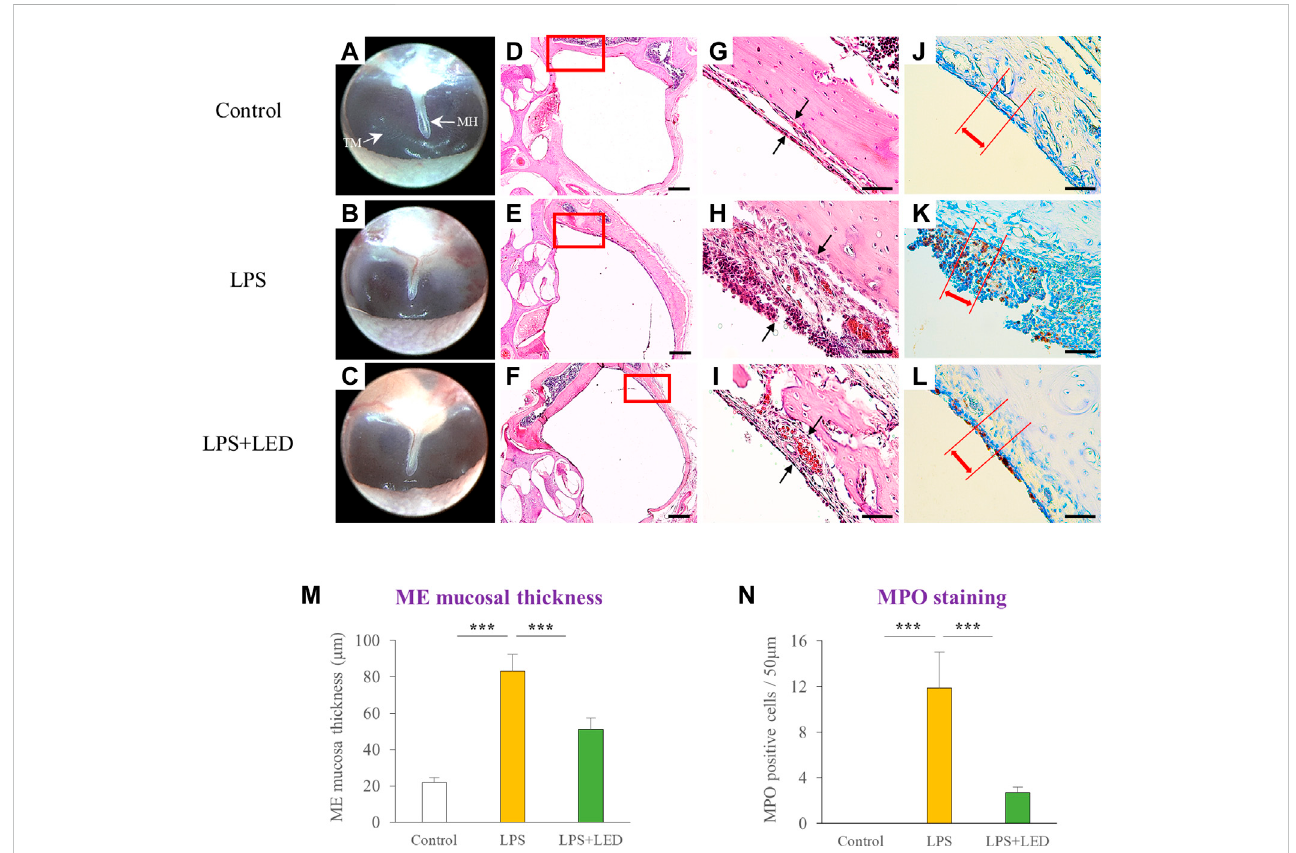
FIGURE 2 Reduction of ME mucosal thickness by LED irradiation. Representative otoscope images of the tympanic membrane of LPS-treated rats with or without LED irradiation on day 3 (A – C) . Representative H&E staining images of the ME histopathology of LPS-treated rats with or without LED irradiation on day 3, magni fi cation ×2.5 (D – F) and ×40 (G – I) . Scale bars represent 500 µm (D – F) and 50 µm (G – I) . Immunohistochemical detection of MPO positive cells in LPS- treated rats with or without LED irradiation on day 3 (no positive cells in fi ltration was observed in the control) (J – L) . Scale bars represent 50 µm (J – L)